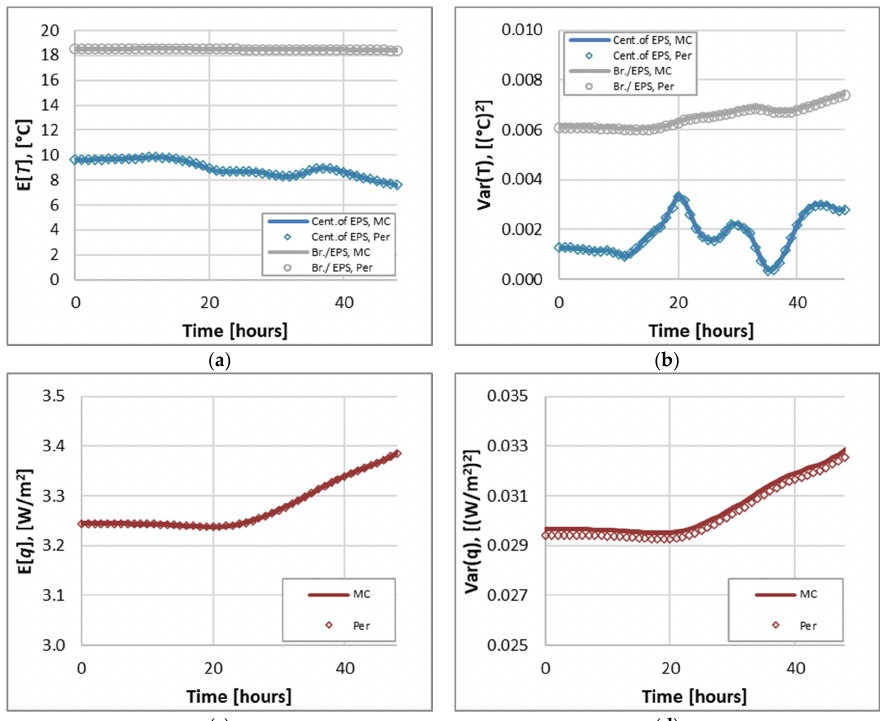
Figure 7. Comparison of ( a ) expected values and ( b ) variance of temperature in Point 3 (“Br./EPS”) and Point 4 (“Cent.of EPS”) and ( c ) expected values and ( d ) variance of heat flux during the first 48 h of the calculations using the Monte Carlo method (“MC”) and the perturbation method (“Per”) for Case 2.